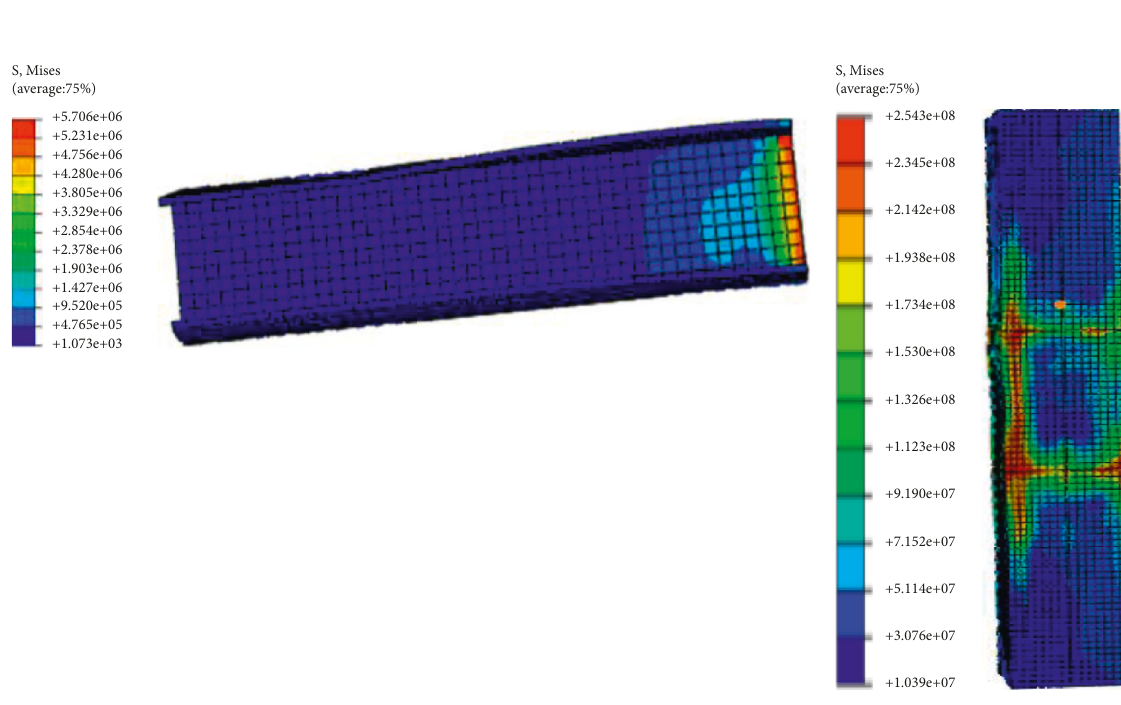
Figure 9: The stress distribution of steel beam and steel tube. (a) Steel beam and (b) steel